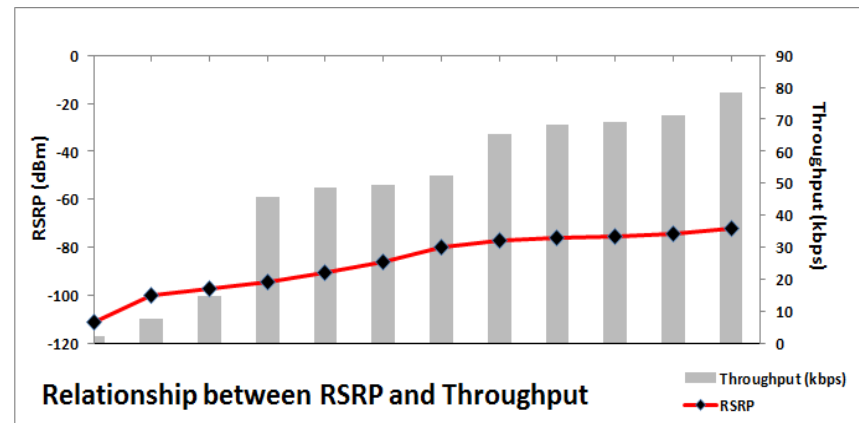
Figure 3. Resolution vs. bit-rate.